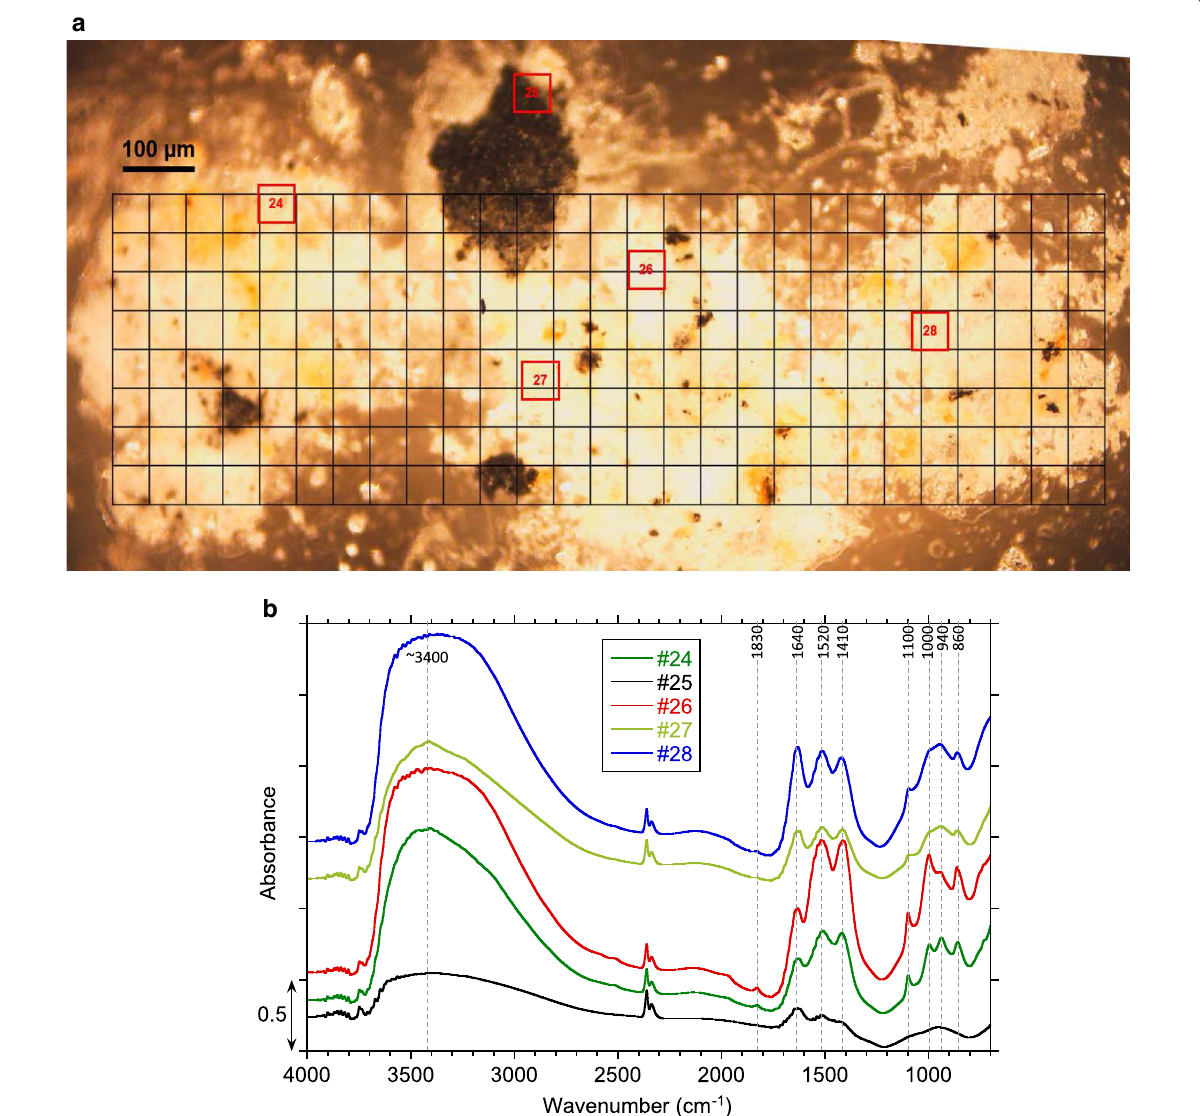
Fig. 9 a Optical microscopy image of the carbonaceous sample from the quenched product. b IR spectral signatures obtained from the red squares (#24, 26–28 are from white materials and #25 is from black material). Possible peak assignments with references (Socrates 2004) are shown in Table